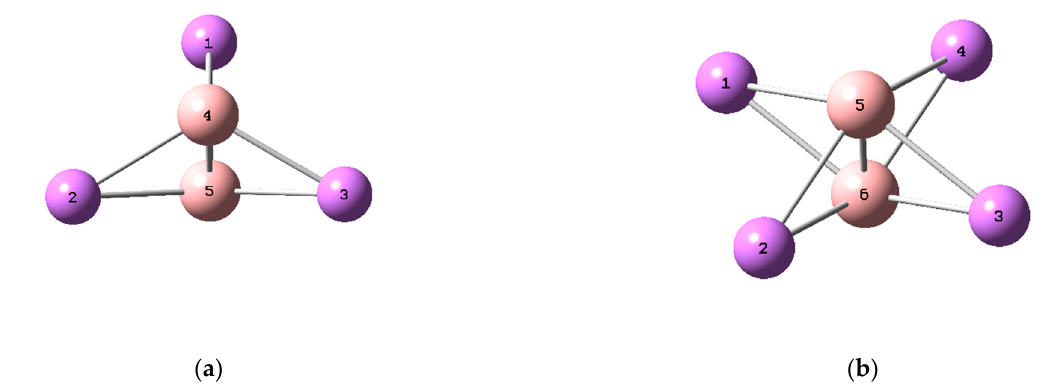
Figure 1. Optimized structures of Li 3 B 2 − ( a ) and Li 4 B 2 ( b ) obtained at the M06-2X/def2-TZVP level of theory.